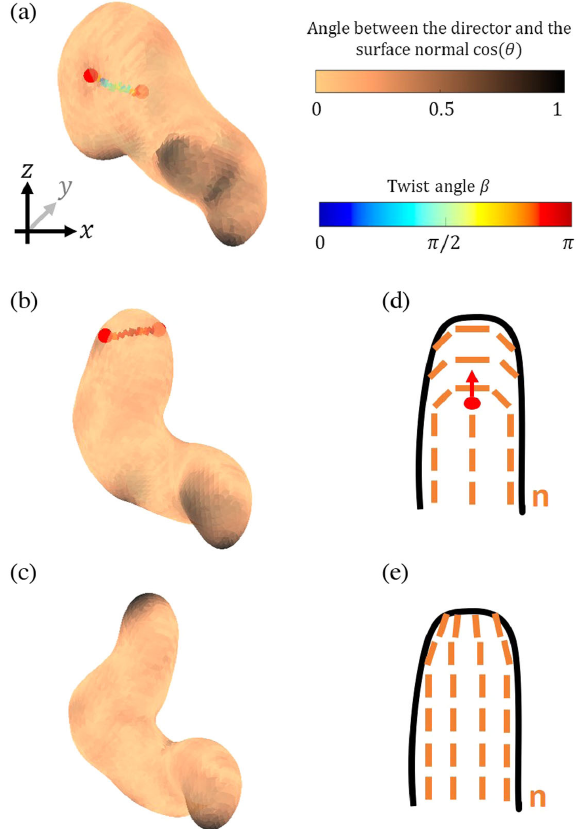
FIG. 9. Formation of fingerlike protrusions by motile discli- nation lines shown by three snapshots at times t 1 < t 2 < t 3 . (a) – (c) show the three-dimensional droplet shape with color coding showing the local surface alignment of the director field. Disclination line segments are colored according to the twist angle β with the same color coding as in Fig. 6. (a) Disclination line with varying twist angle β moves toward the interface. Active flow pushes the interface outward, creating a bulge along the self- propulsion direction of the disclination line. (b) The small protrusion width combined with in-plane alignment at the surface stabilizes the disclination line into an almost straight configura- tion with β ≈ π . (c) The disclination line moves out of the droplet, leaving behind a defect-free protrusion with an aligned director field. Disclination lines exit protrusions as nearly straight lines and violate in-plane alignment within a small area, as active anchoring is not strong enough to force the creation of a surface point defect. (d) and (e) show a schematic diagram of the director field and active forces. The red arrow in (d) denotes the self-propulsion direction of the β ≈ π disclination lines. As shown in (c), disclinations leave behind an area of perpendicular surface alignment (dark regions) at the end of protrusions which slowly retract due to surface tension and bending rigidity. Snapshots created from simulation with droplet size R ¼ 15 at times t 1 ¼ 71 500 , t 2 ¼ 72 500 , and t 3 ¼ 73 500 ; see also Movie S2